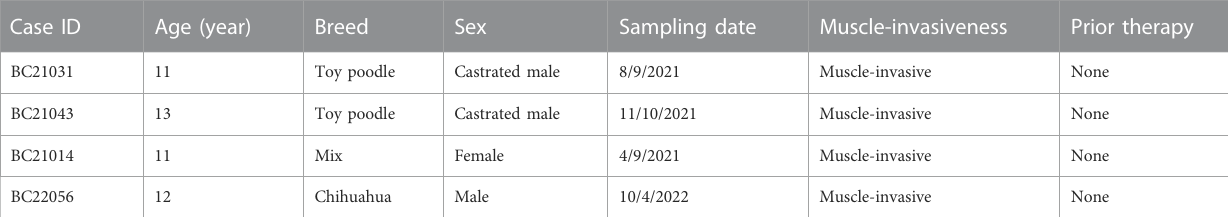
TABLE 1 Sample information.